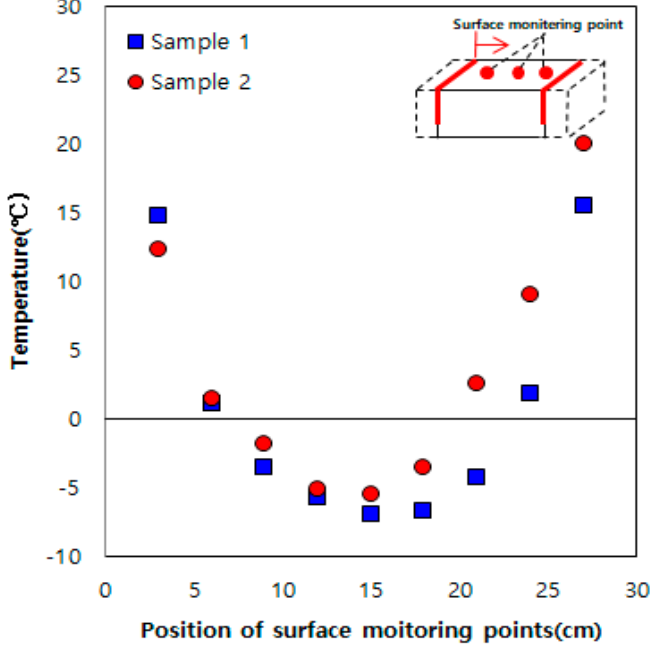
Figure 6. Results obtained using heating elements spaced at 30 cm.